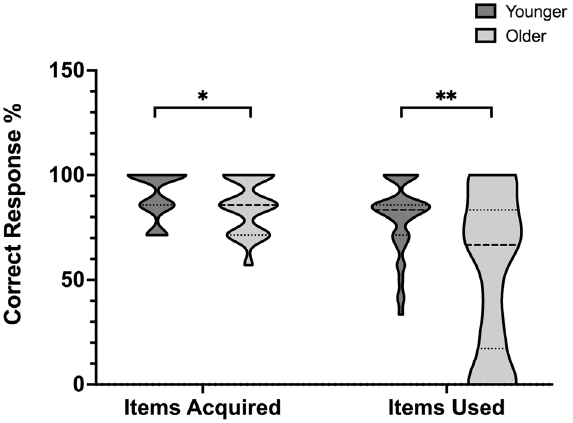
Figure 2. Performance on VW-foresight for younger and older participants. Items acquired and are expressed as a percentage of 7 possible items. Items used (conditionalized) are expressed as a proportion of acquired items that were used. * p < 0.05, ** p < 0.01. VW virtual week.